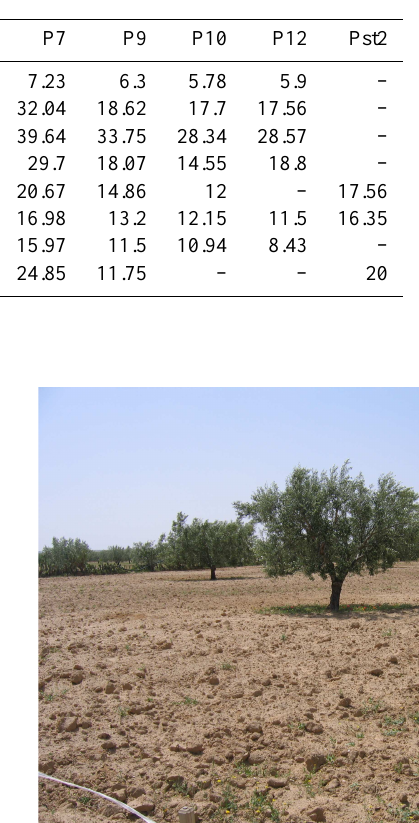
Fig. 2. View of a typical non-irrigated olive tree field.